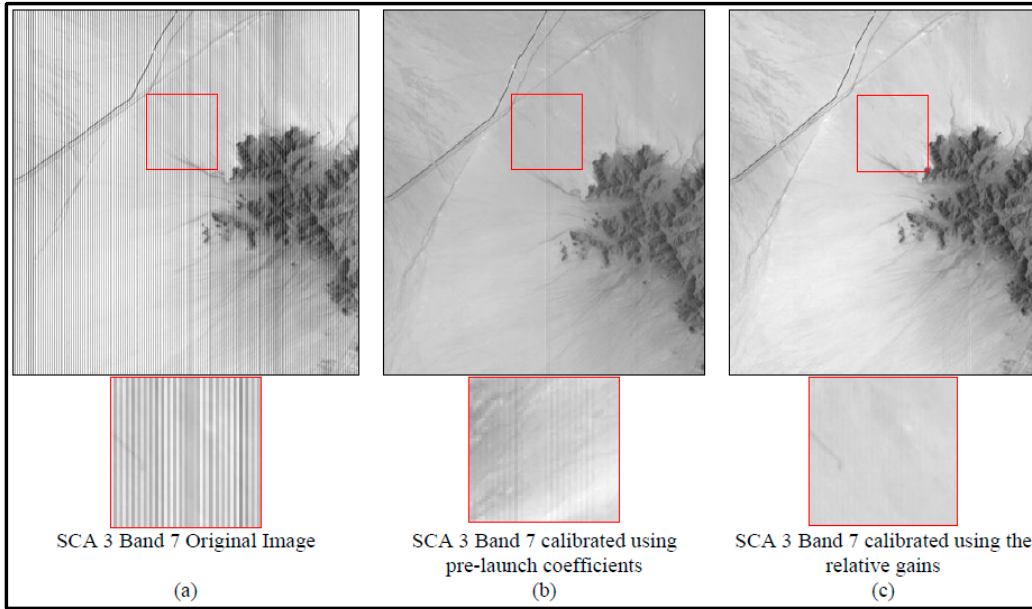
Figure 9. Relative gain applied on ALI Arizona scene [136].